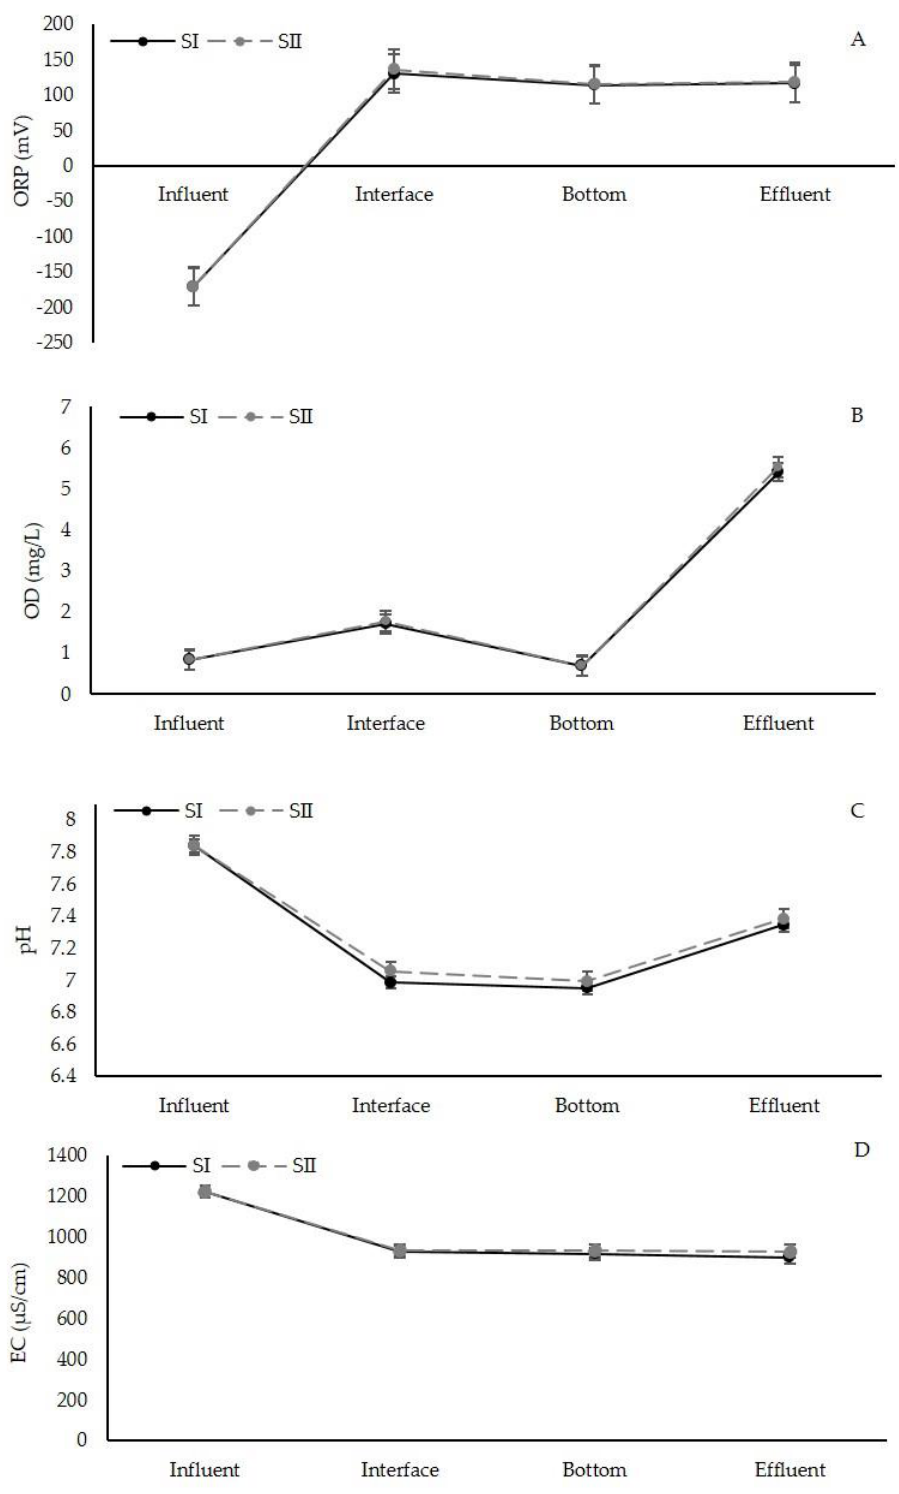
Figure 6. Internal conditions of the PS VF wetlands during the study: Oxidation-reduction potential (ORP) ( A ), OD ( B ), pH ( C ), electric conductivity (EC) ( D ).